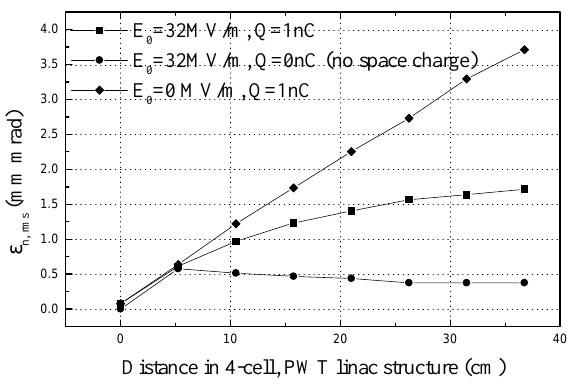
FIG. 12. Emittance variation in the 4-cell, PWT linac structure with different accelerating field gradients and pulse